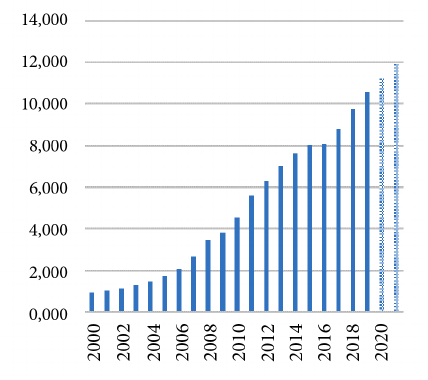
Figure 2. GDP per capita in China, 2000–2021, $ thousands (source: authors’